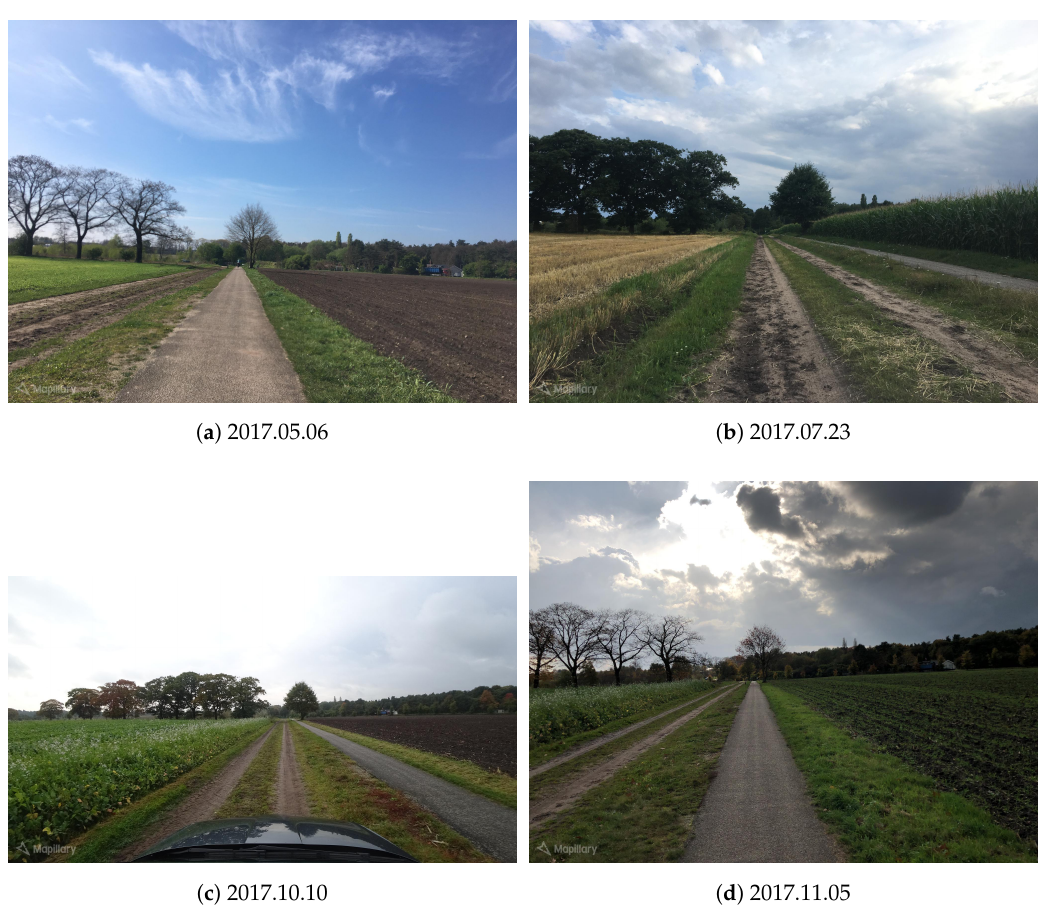
Figure 14. On the left parcel grass was followed by a cover crop, on the right parcel, maize was followed by a winter cereal. Also note the leaf on/leaf off condition of the trees in the background, which provides seasonal context. (latitude = 51.9922 ◦ N,longitude = 5.7421 ◦